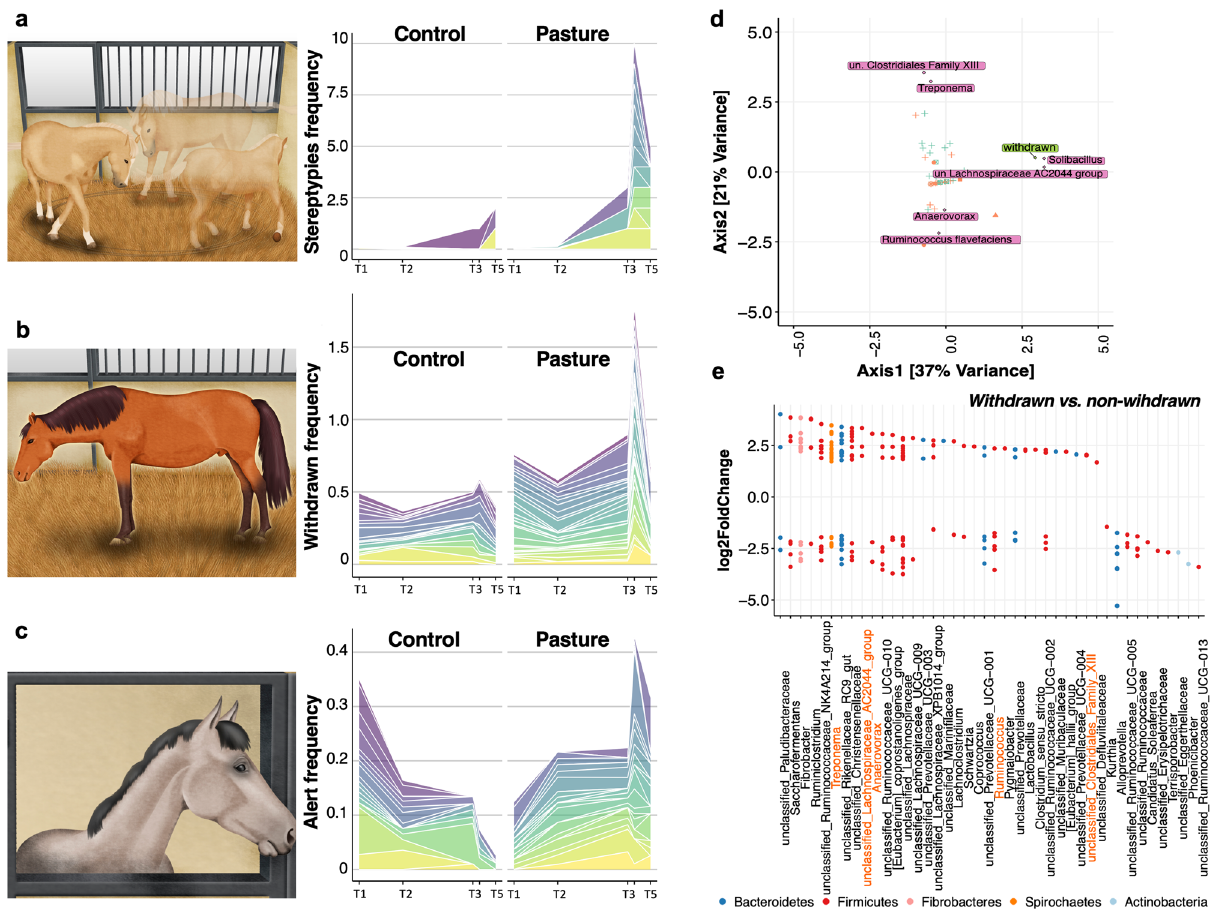
Figure 5. Association between the temporal dynamics of the fecal microbiota and behavioral parameters three months post-pasture. ( a ) Stacked area chart displaying the evolution of stereotypies frequency in control and pasture groups across time; ( b ) stacked area chart displaying the evolution of withdrawn frequency in control and pasture groups across time; ( c ) stacked area chart displaying the evolution of alert behavior frequency in control and pasture groups across time. In all cases, the measurements were done at baseline time (from T1 to T3), immediately at the returning in the box and three months later (T5). The frequency values of the individuals within each group are presented on top of each other ; ( d ) sparse canonical correspondence analysis (CCA) ordination plot of ASVs abundance table and results of the analysis of behavioral variables affecting bacterial divergence. Significant behavioral variables are indicted as rectangles, and ASVs associated to the correspondent significant variable are depicted in diamonds with text labels. If the annotation at the specie level of each significant ASVs were not found, the genera was specified; ( d ) dot plot representation of log-transformed fold change of ASVs that were significantly different between horses expressing withdrawn behavior and those non-expressing the withdrawn behavior. The log of fold changes superior to 0 indicate that ASVs were more abundant in the individuals expressing withdrawn behavior. By contrast, the log of fold changes inferior to 0 indicate that the ASVs abundances were lower in individuals expressing withdrawn behavior. Dots are grouped by genera and colored by phyla. All plots were produced in R software https :// www.r-proje ct.org, using the version 4.0.2. The drawings corresponding to the stereotypy and withdrawn behaviors in the panel ( a ) and ( b ), respectively, have been obtained from Mach et al. 8 and used according to terms of a Creative Commons Attribution 4.0. License: http://creat iveco mmons .org/licen ses/by/4.0/. No changes were made. Written permission for publication of the drawing concerning to the alert behavior (panel c ) in the figure has been